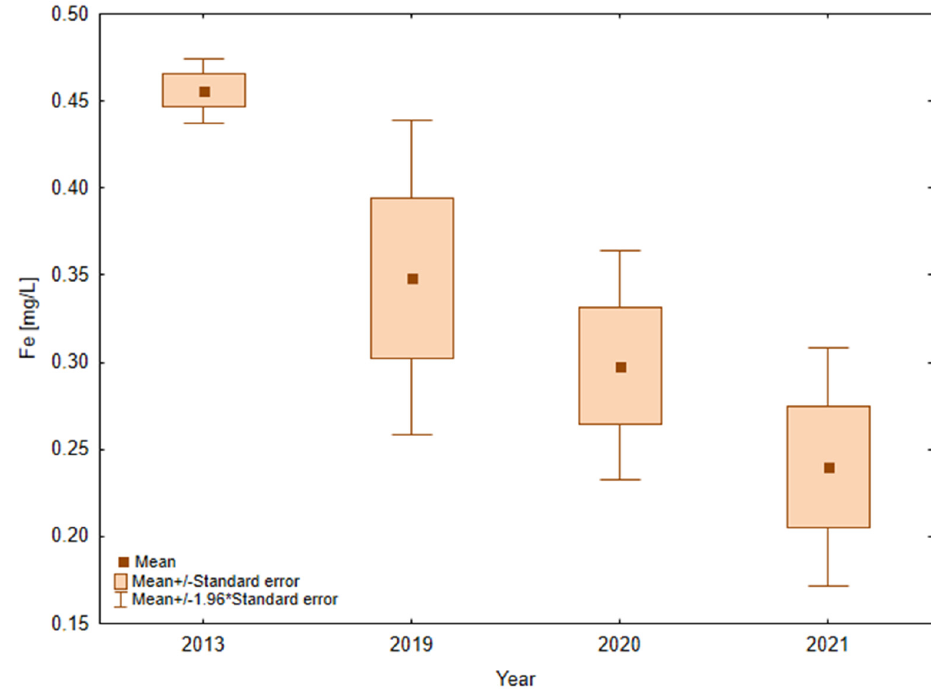
Figure 6. Average annual values of Fe content in the water of Lake Mielenko. In the water of Lake Mielenko, manganese concentrations fluctuated in the range of 0.14 to 0.74 mg Mn/L. After the creation of a road salts disposal area, manganese concentrations in the water did not change significantly. In 2013, the during inflow of stormwater before changes of the use of the catchment area, the average concentration of Mn in the water was 0.35 ± 0.07 mg Mn/L (Figure 7). In 2021, the average concentration of Mn in the water was 0.30 ± 0.15 mg Mn/L.